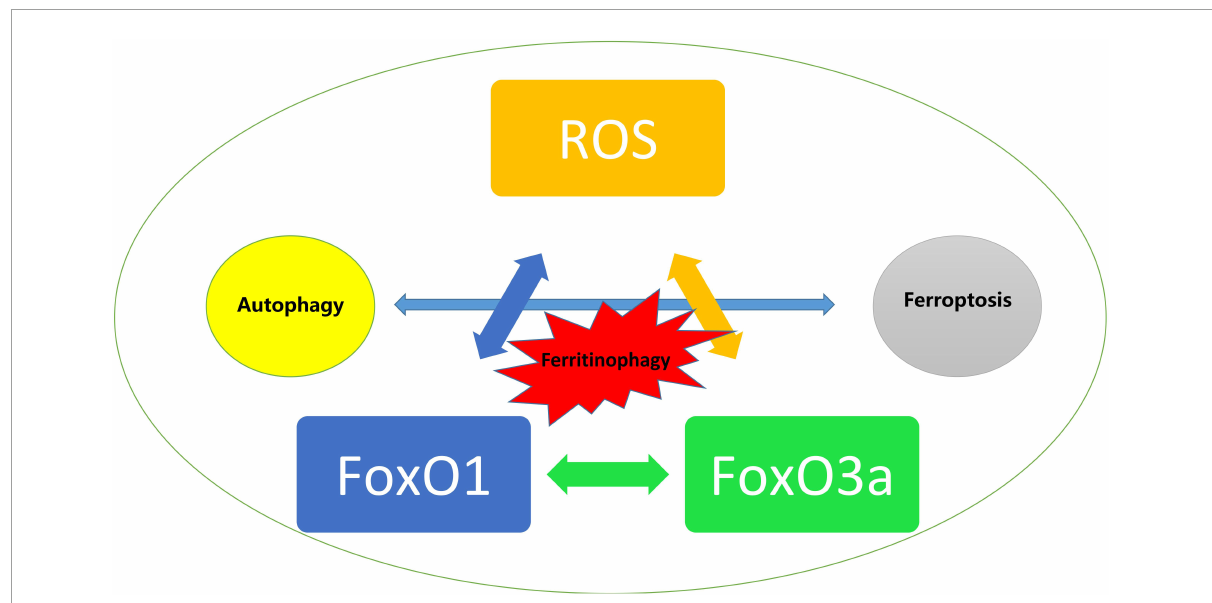
FIGURE4 Trigger of ROS mediated activation of FoxO and the impact on autophagy and ferroptosis in diabetic